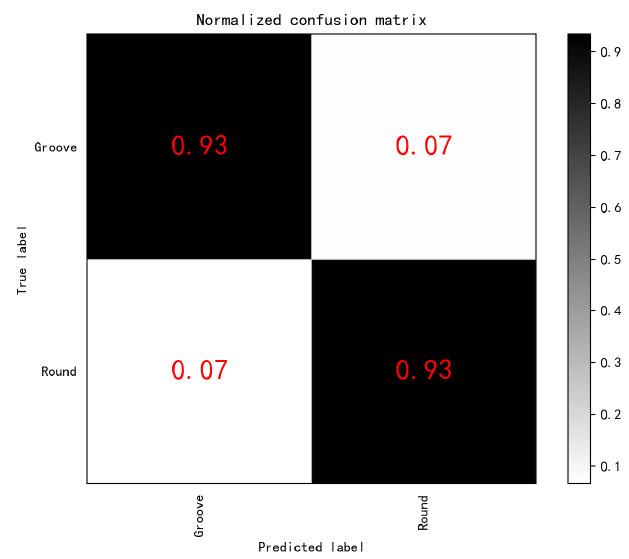
Figure 9. SVM for Normalized confusion matrix.